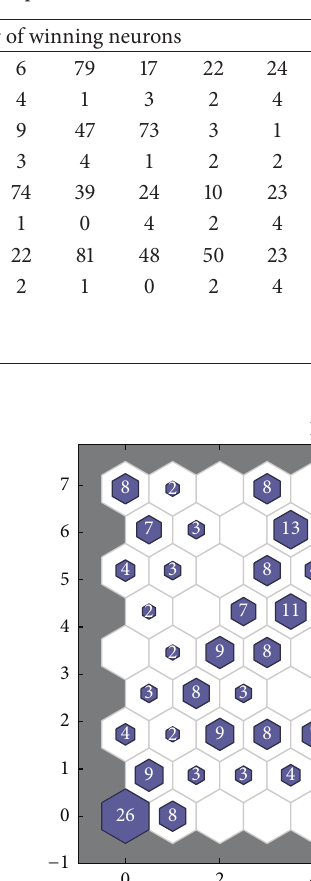
Table 4: Comparison between actual values and predicted values of SOM neural network.